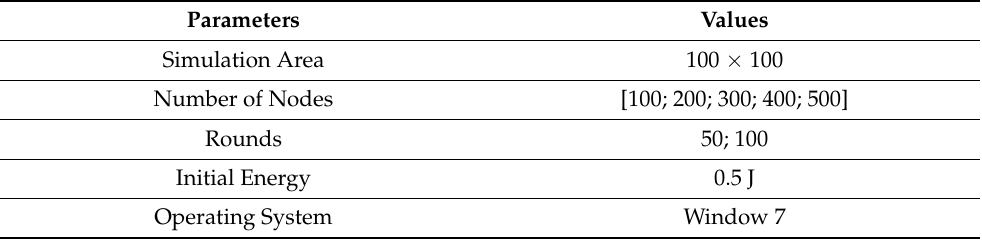
Table 1. Simulation parameters.